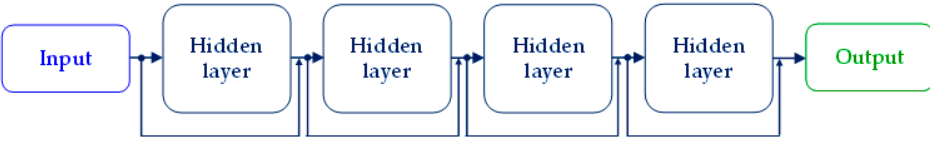
Figure 13. Generalization of ResNet principle with several hidden layers.